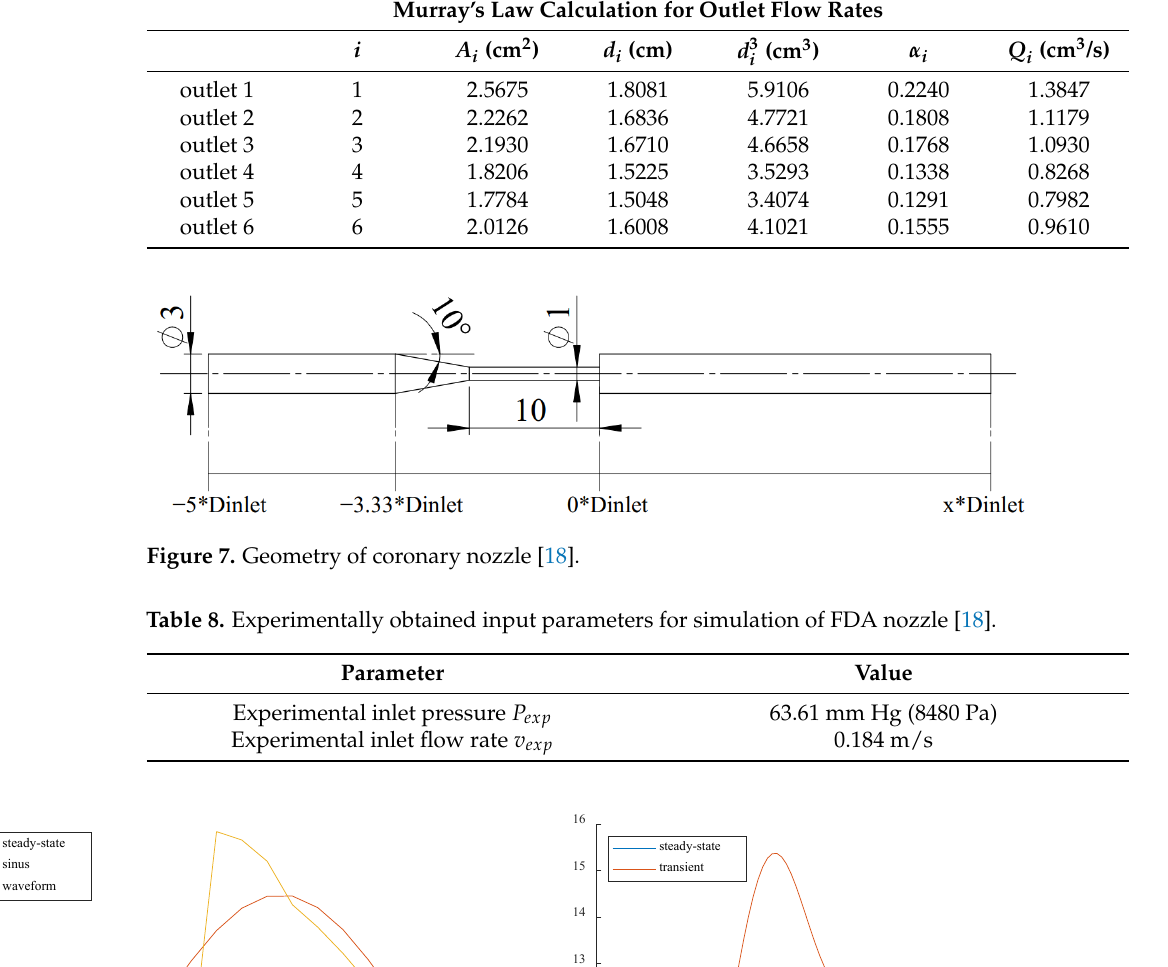
Table 8. Experimentally obtained input parameters for simulation of FDA nozzle [18] .